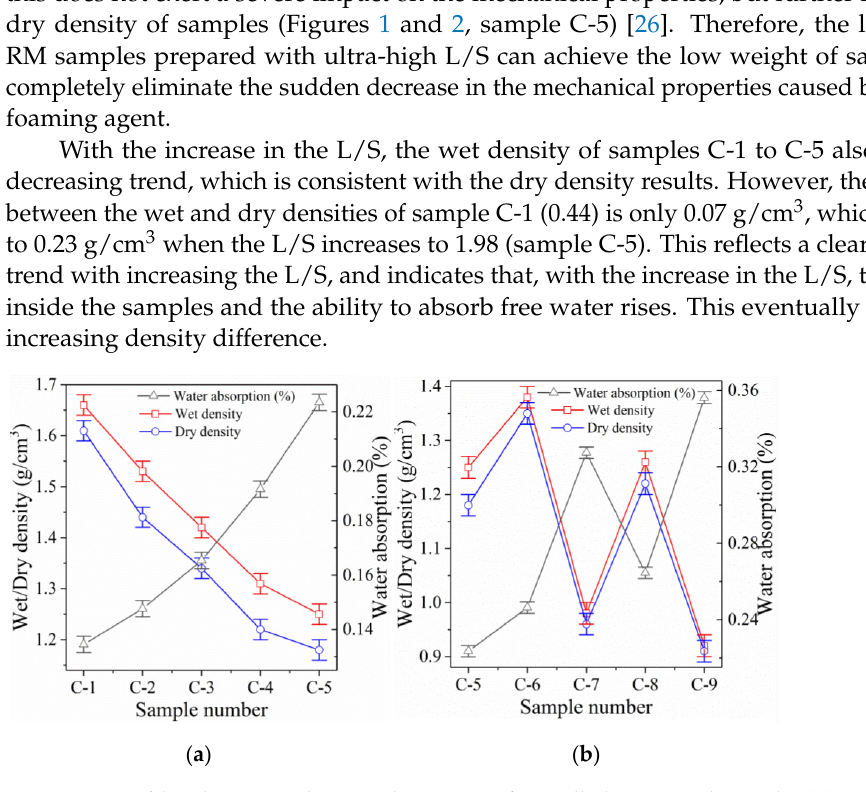
Figure 2. Wet/dry density and water absorption of RM alkali-activated samples ( a ) Samples C-1 to C-5 and ( b ) Samples C-5 to C-9.